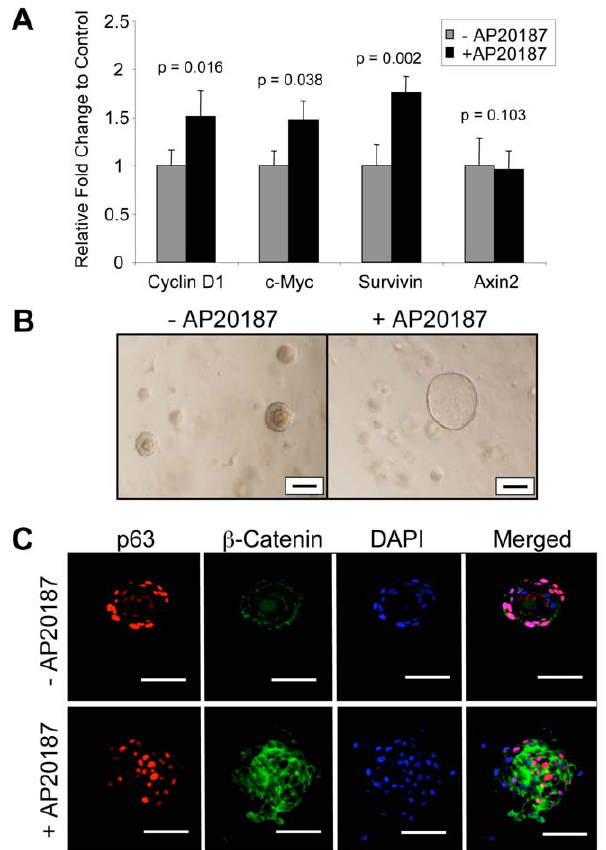
Figure 8. Invitro analysis of iLRP5 activation in prostate B/SCs. ( A ) qRT-PCR analysis of Wnt target genes. LSCs were cultured in Matrigel for 6 days with or without CID (100 nM). Cells were isolated and RNA was collected for cDNA synthesis and qRT-PCR analysis. CID- mediated iLRP5 activation promotes Wnt target genes expression. Error bars represent StDev of 3 experiments, normalized to 18S RNA ( B ) Prolonged (16 days) activation of iLRP5 promotes enlargement of prostaspheres. Control spheres grew to maximum size of 150–200 m m; however, CID-treated spheres grew to 300–400 m m. Bar=100 m m. ( C ) Analysis of p63 and b -catenin expression in prostasphere cross-sections. iLRP5 activation enhances b -catenin stability. CID-treated spheres reveal dispersed distribution of p63 + cells within all layers of prostasphere. Bar=100 m m.